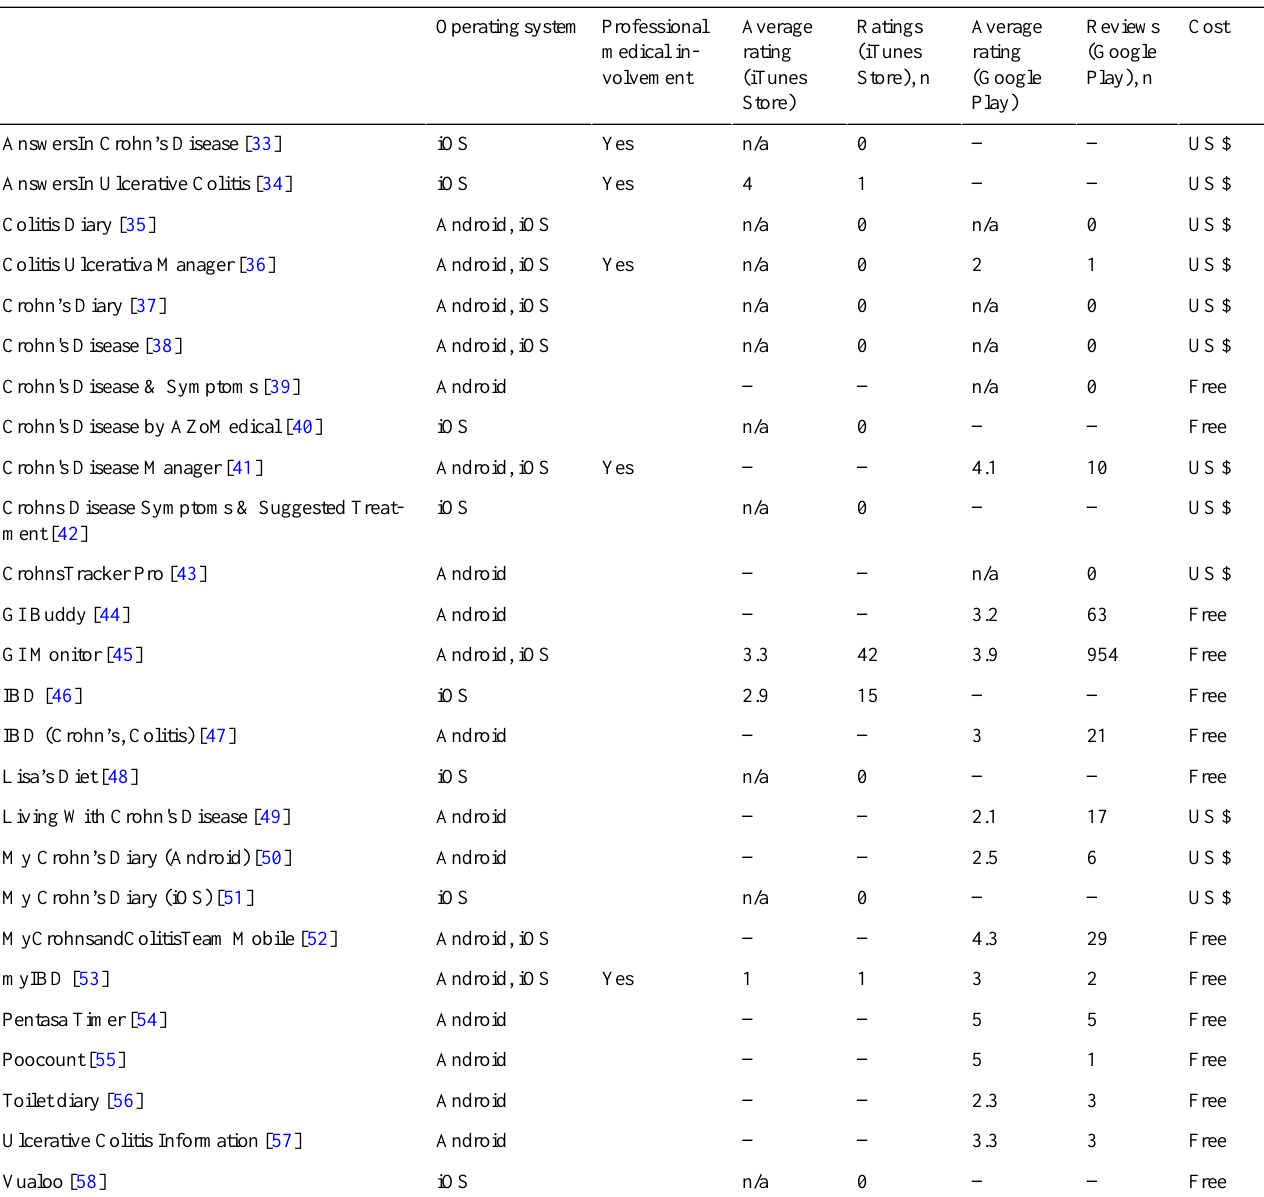
Table 3. Summary of assessed